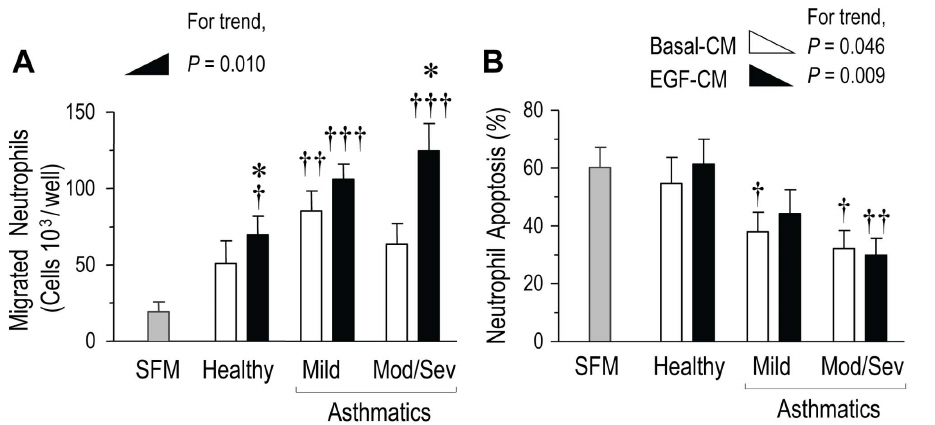
Figure 2. Neutrophil chemotactic and anti-apoptotic activity generated by EGF-induced bronchial epithelial cells. Conditioned media (CM) from 9 healthy control subjects, 8 mild and 11 Mod/Sev asthmatics were assessed for neutrophil chemotactic and anti-apoptotic activity as described in Methods. (A) Neutrophil chemotaxis was significantly induced by stimulation of PBECs with EGF in HC (p=0.021) and Mod/Sev asthma (p=0.010) but not in MA (0.093). The chemotactic activity in EGF-CM was related to the clinical severity of asthma (linear contrast test p=0.010) ( n =8 donors). (B) Neutrophil apoptosis was assessed after 20 h of culture by FACS analysis of Annexin-V FITC /PI staining and both basal and EGF-CM from the asthma-derived PBECs, but not from HC, contained significant neutrophil anti-apoptotic activity when compared to SFM (MA, p=0.047 and Mod/ Sev, p=0.014; HC, p=0.603, respectively). The anti-apoptotic activity in basal-CM and EGF-CM increased in relation to disease severity (p=0.046 and 0.009, respectively, as assessed by trend analysis), ( n =7 donors). Repeated one-way ANOVA with post-hoc Bonferroni; { p , 0.05, {{ p , 0.01 and {{{ p , 0.001 compared to SFM-treated neutrophils. *p , 0.05 vs. basal-CM.